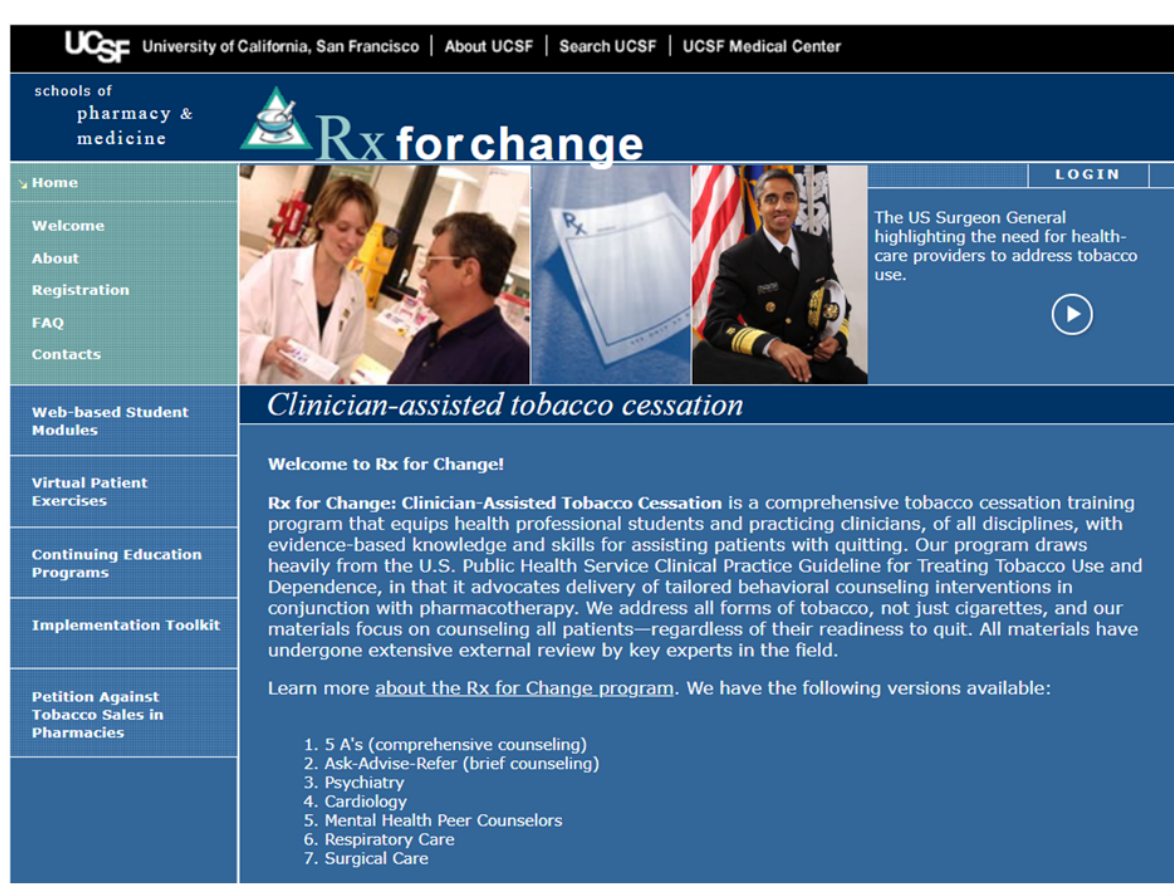
Figure 1. Rx for Change website homepage [10].